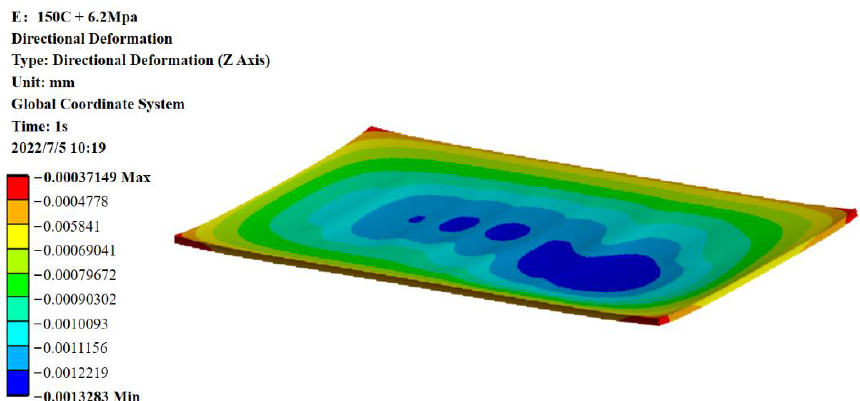
Figure 12. The collapse result after the roof layer process obtained by applying 6.2 MPa pressure to the FE model.